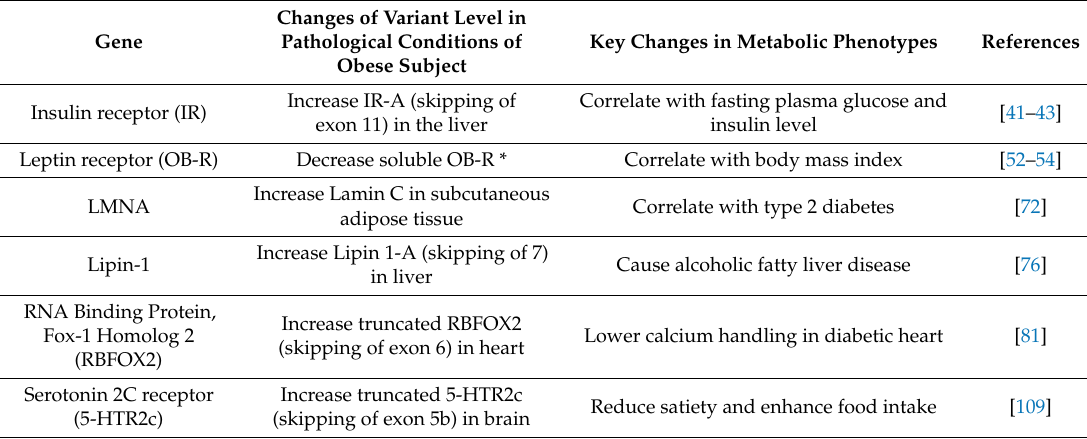
Table 2. Summary of the splice variants described in this review known to play a role in metabolic